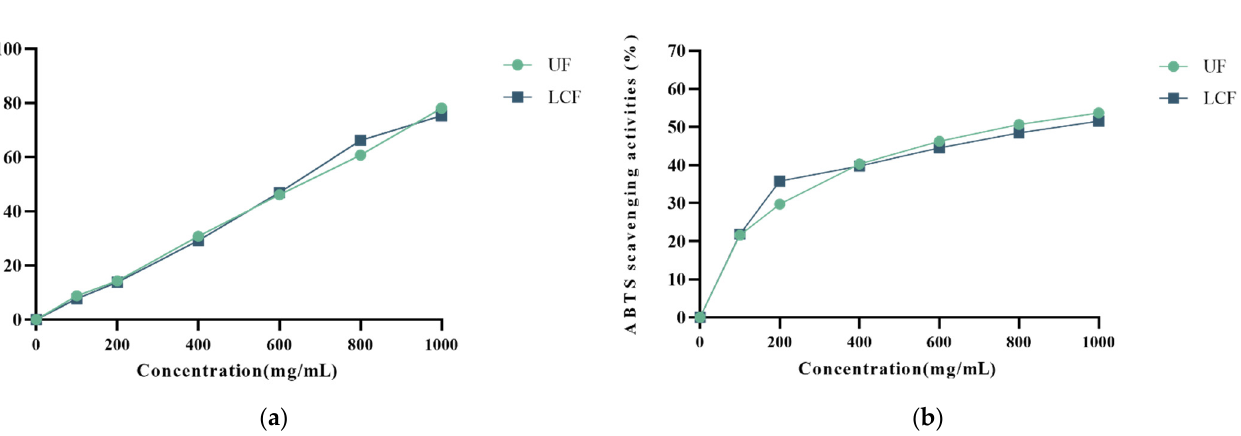
( b ) Figure 5. Effects of UF and LCF on HSF cell viability: ( a ) cytotoxicity of UF and LCF; ( b ) protective effects of UF and LCF on H 2 O 2 -damaged HSF; UF: unfermentation; LCF: single microbial fermentation with L. curvatus. Analysis of significant differences between each group and H 2 O 2 model group, #: p < 0.05; ##: p < 0.01; ###: p < 0.001.; comparison of each group between UF and LCF, *: p < 0.05; ***: p < 0.001 ; ns: p > 0.05. 3.5. Effects of UF and LCF on ROS Level Figure 6 shows the intracellular ROS levels after H 2 O 2 irradiation and incubation in both systems. Intracellular ROS levels rose after H 2 O 2 injury, affecting the antioxidant capacity. There were significantly lower ROS levels after UF and LCF incubation in a dose- dependent manner compared to the H 2 O 2 damage model. It is also clear that LCF has a